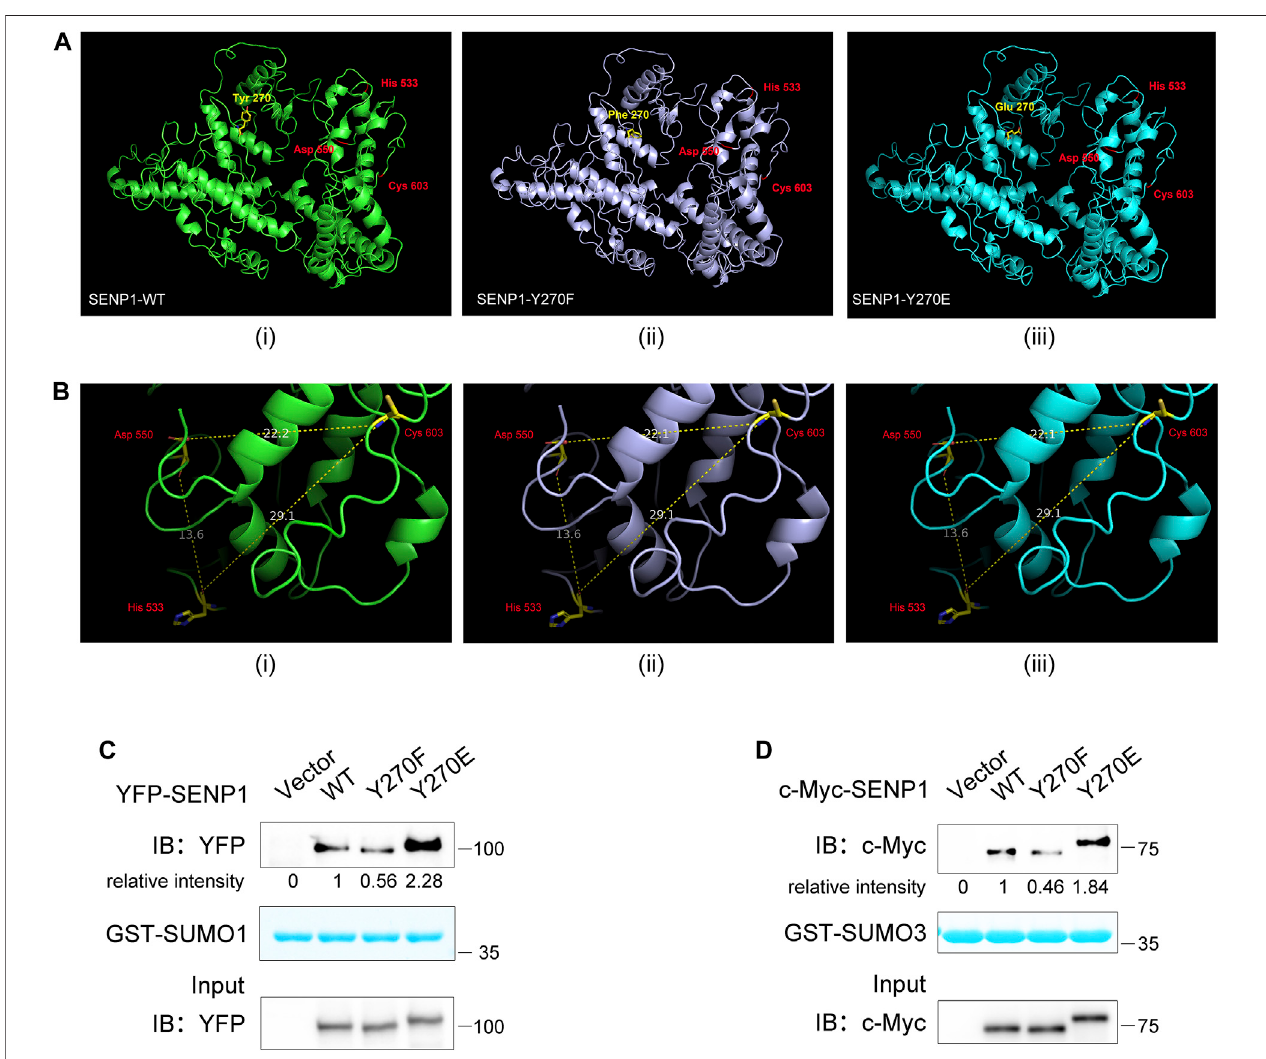
FIGURE 6 | SENP1 Y270 phosphorylation in fl uences its binding propensity for substrates. (A) 3D structural models of SENP1 (full length, 1 – 644aa, (i) , Y270F (ii) , andY270Emutations (iii) . (B) DistancesbetweenkeyresiduesinSENP1WT (i) ,Y270F (ii) ,andY270Estructures (iii) .Theunitofmeasurementfordistanceisangstrom (Å). (C,D) Analysis of SENP1 WT and its mutants binding to GST-SUMO1 (C) and GST-SUMO3 (D) . Puri fi ed GST-SUMO1 (1 – 97 aa) (C) or GST-SUMO3 (1 – 92 aa) (D) proteinsimmobilizedonglutathionebeadswereincubatedwithcelllysatefromHEK293TtransfectedwithSENP1WToritsmutantsY270FandY270E,followedby western blot analysis (top). The densitometric quanti fi cation of bound SENP1 is shown (the relative intensity of SENP1 WT was set as 1). Coomassie staining of GST- SUMO1 or GST-SUMO3 (middle) and immunoblots of WCL of HEK293T transfectants (bottom) are shown.